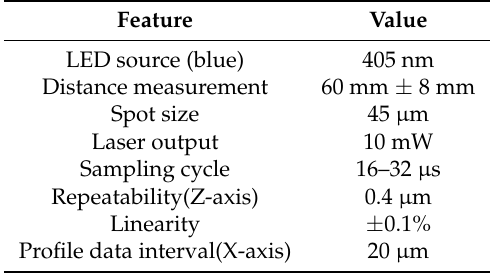
Table 1. Technical features of the new LJ-V7060 profilometer.